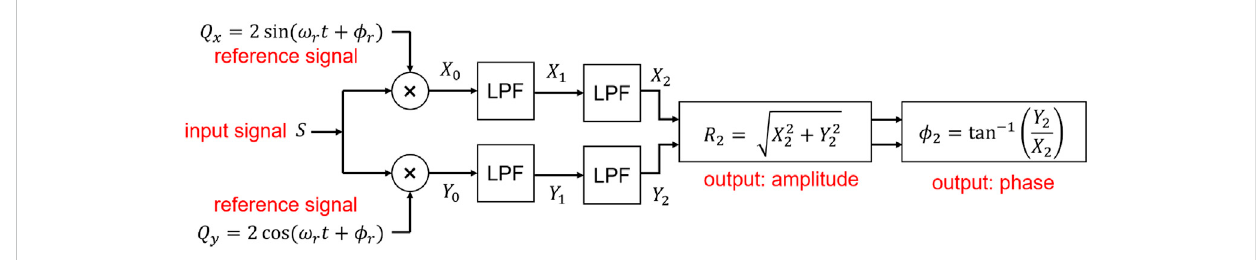
FIGURE 1 Block diagram summarising analysis procedure. An input signal S is multiplied by orthogonal sinusoidal reference signals Q x and Q y . The resulting